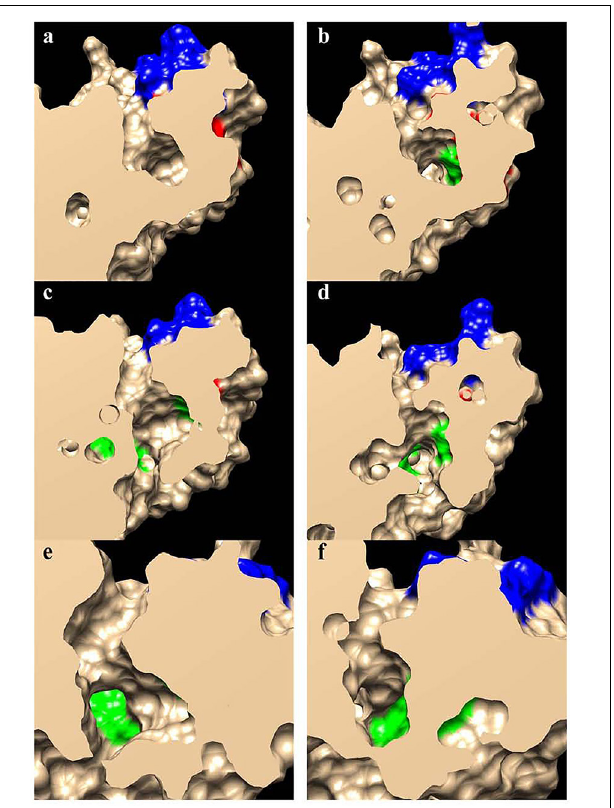
FIGURE 5 | Slab views of the substrate binding pockets for Ha FatA (a,c,e) and Ha FatB (b,d,f) . The residues involved in the substrate interaction described by Feng et al. (2017) are shown in green, those involved in catalysis are in red and those involved in the positively charged surface patches surrounding the opening of the pocket are in